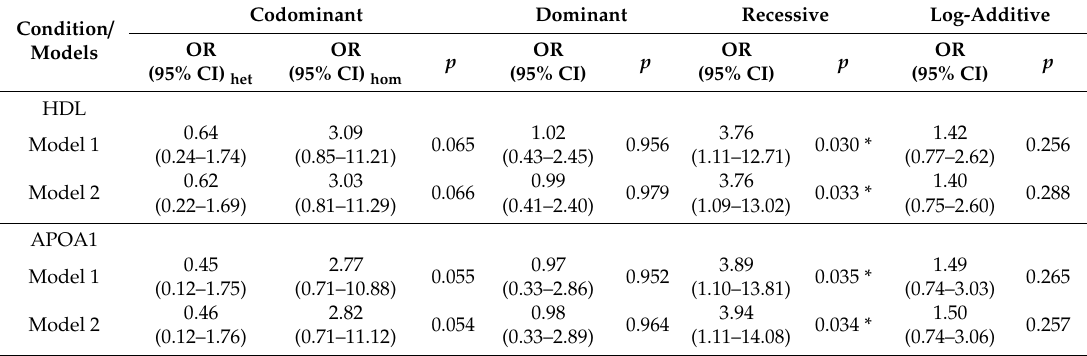
Figure 2. Correlation analysis between the APOA2 rs3813627 SNP and HDL and APOA1 levels. Correlation between the APOA2 rs3813627 polymorphism and ( a ) HDL ( n = 91) and ( b ) APOA1 ( n = 65) levels under recessive model (GG + GT and TT) in overweight / obese (BMI ≥ 25 kg / m 2 ) individuals according to the Pearson’s correlation test ( p < 0.05). Abbreviations: BMI, body mass index; HDL, high density lipoprotein; APOA1, apolipoprotein type A1; APOA2, apolipoprotein type A2. Table 5. Genotypic and allelic frequencies APOA2 rs3813627